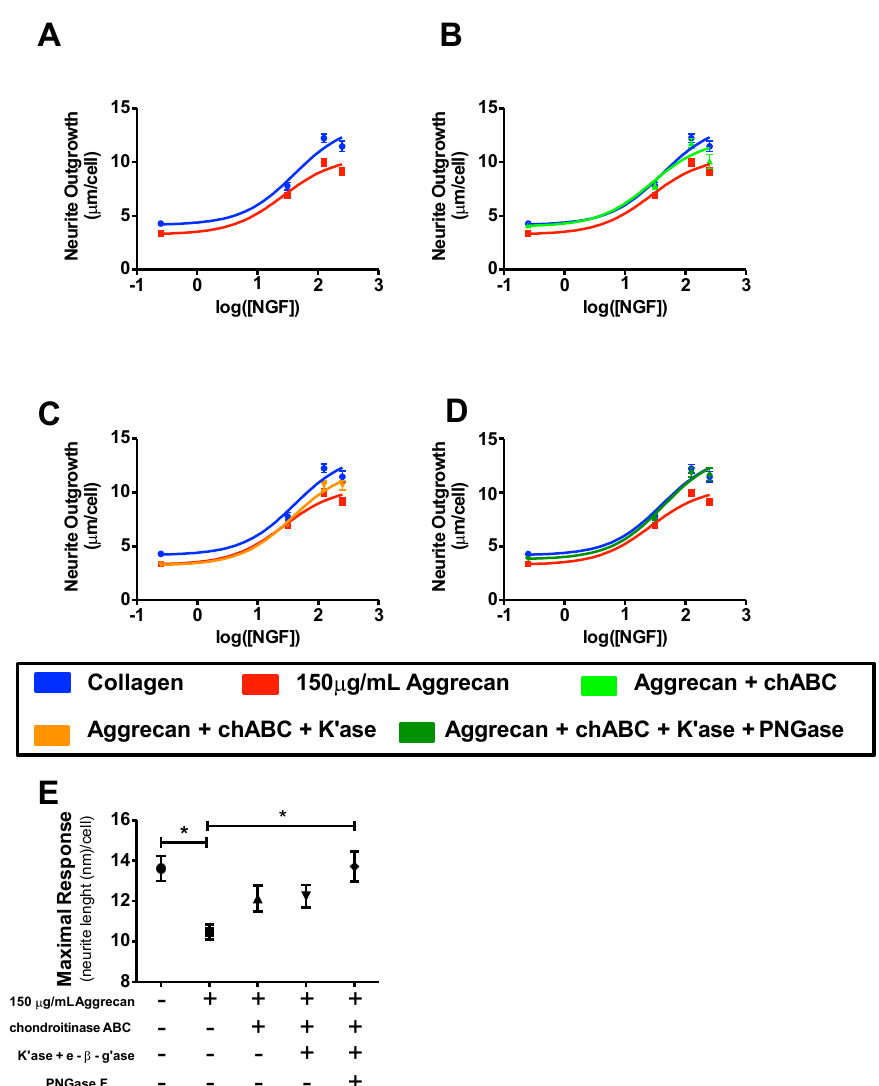
Figure 6. Inhibition of neurite outgrowth by enzymatically modified aggregan. ( A – D ) Dose response curves comparing neurite growth on collagen substrate alone and collagen plus undigested or variably digested aggrecan. The results for collagen only and collagen + undigested aggrecan are shown in each panel for comparison. ( A ) Intact aggrecan ( B ) chondroitinase ABC; ( C ) chondroitinase ABC + keratanase II / endo- β -galactosidase digestion; ( D ) chondroitinase + keratanase II / endo- β -galactosidase + PNGaseF digestion. ( E ). Statistical analysis: the first comparison (first bar) was between collagen and undigested aggrecan. The second comparison (second bar) was between intact aggrecan and variably enzyme digested aggrecan. * p < 0.05 following bonferonni post-hoc analysis.